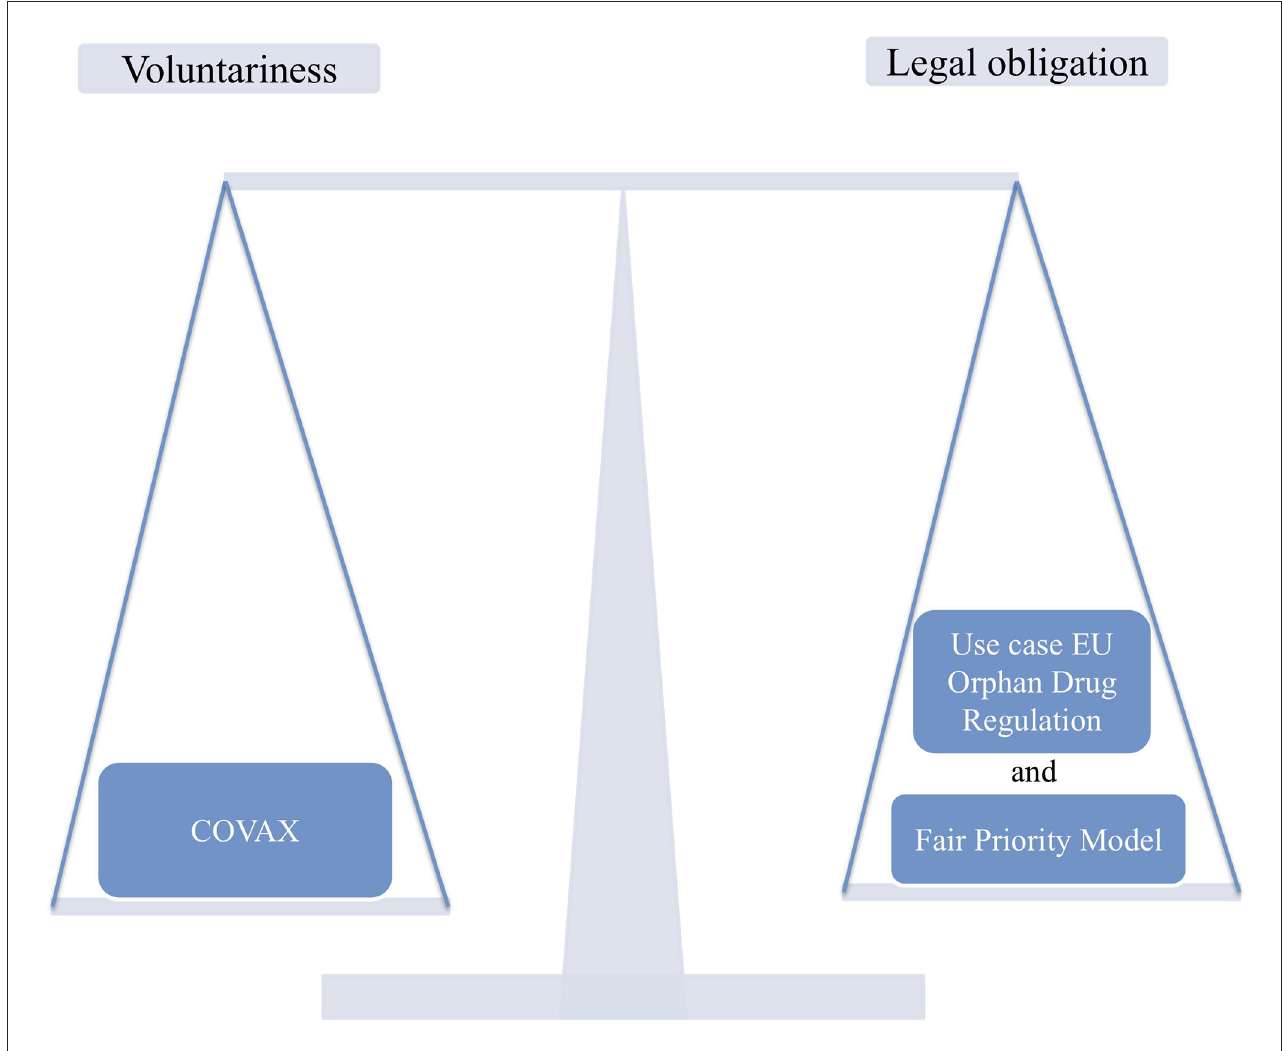
FIGURE1 Comparison of two strategies for fairer global access to COVID-19